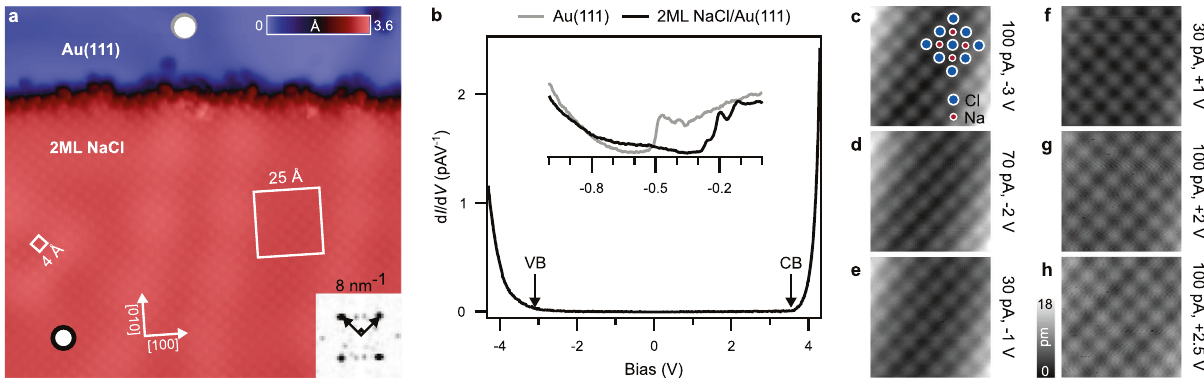
Fig. 1 STM of 2 ML NaCl(100) on Au(111) with topography and d I/ d V measurements. a Overview of the measurement area (150 × 140Å 2 , I T = 8 pA, V = − 50 mV). 25 × 25 Å 2 region marked, investigated for bias values between − 3.0 V and + 2.5 V. Inset: Fourier transform of f centred over a S 8 nm − 1 × 8 nm − 1 region in reciprocal space. b Differential conductance (d I/ d V ) measured atop 2 ML NaCl(100)/Au(111) (marked by the black ring in a ). The arrows point to onset of valence band (VB) and conduction band (CB). Inset. Surface state features of Au(111) and related interface state of 2 ML NaCl(100)/Au(111) measured at the positions marked in a by a grey ring and a black ring, respectively. Vertical scale: arbitrary units. c – h Raw data showing grayscale topography images obtained for sample bias between − 3.0 V and + 2.5 V as indicated. The red and blue dots in c mark the positions of Na and Cl ions of the NaCl(100) lattice, respectively. The corresponding tunnelling parameters (current, voltage) are indicated next to each topography